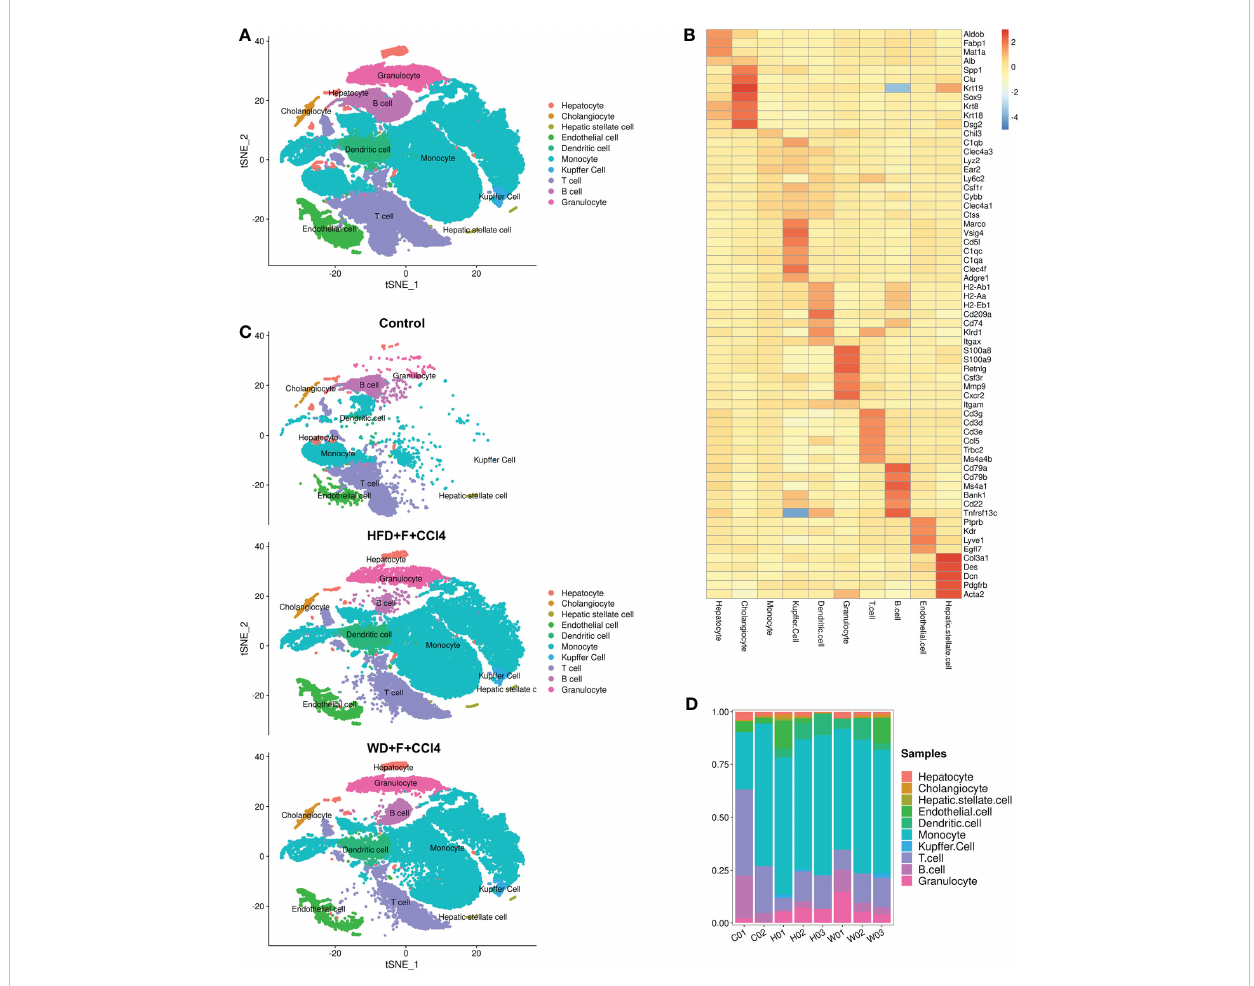
FIGURE 2 ScRNA-seq pro fi ling of liver cells from normal and NASH mice with fi brosis. (A) The annotation and color codes for the 10 identi fi ed liver cells. (B) The t-SNE plot shows the cell origins in the control, HFD+F+CCl4 mice and WFD+F+CCl4 mice. (C) Heatmap showing the expression of marker genes in the indicated cell types. (D) Histogram indicating the proportion of cells in the liver tissue of each mouse. ps: C01-02: control mice 01-02; H01-03: HFD+F+CCl4 mice 01-03; W01-03: WFD+F+CCl4 mice